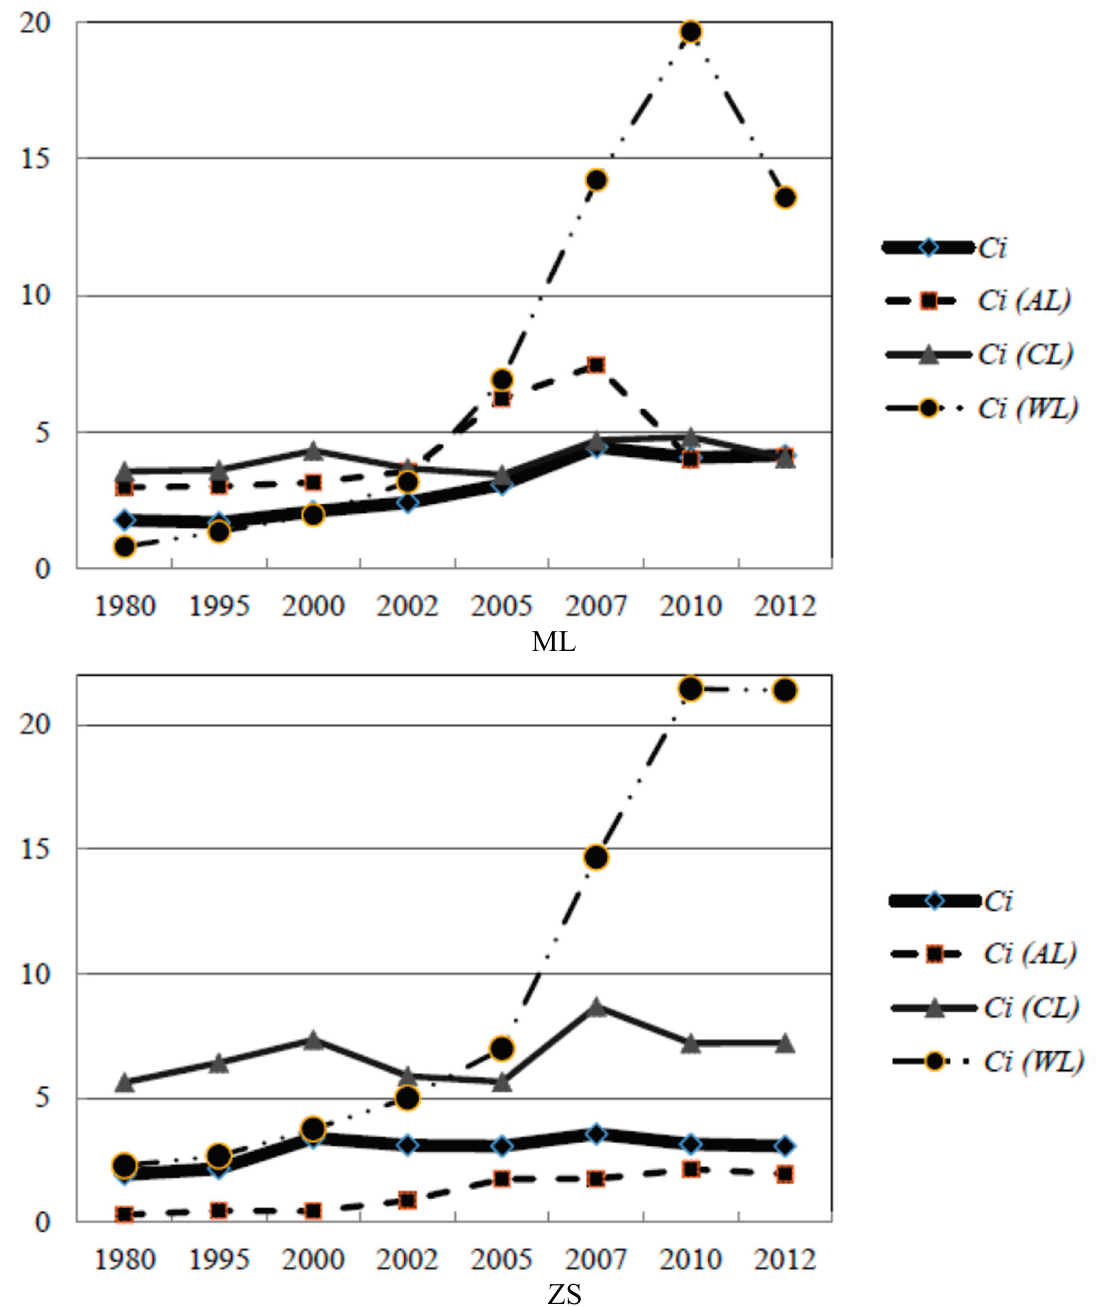
Figure 6. Change tendency of Ci in land level and in land class